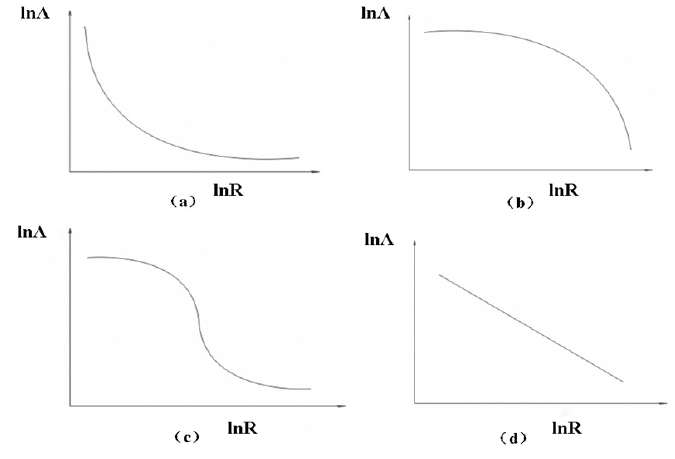
Figure 2. Four possible decreasing trends of the lacunarity index: ( a ) concave curve type, ( b ) convex curve type, ( c ) reverse curve type and ( d ) linear type.